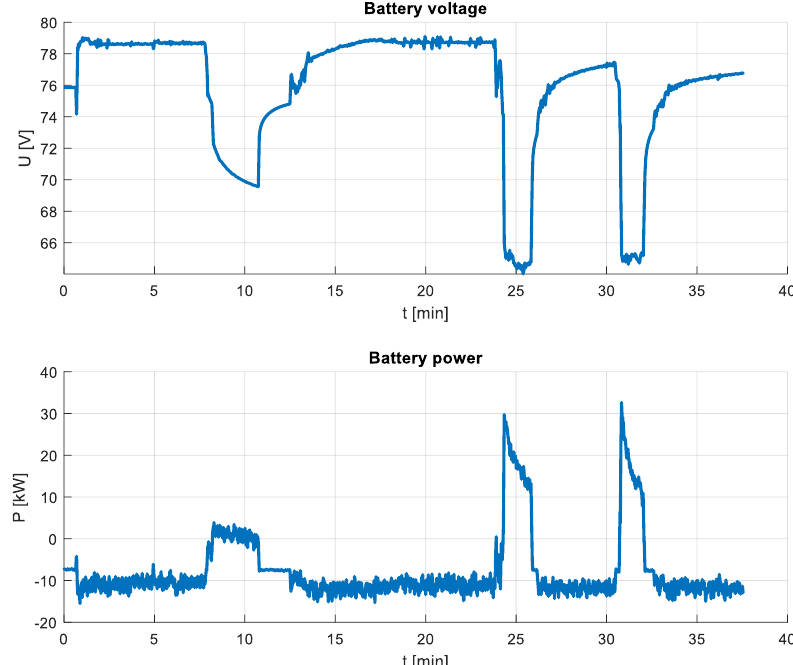
Figure 8. The courses of the battery voltage and power in the field tests of the tractor-trailer unit: minutes 8 to 11 — driving a loaded tractor-trailer unit up a 5° hill; minutes 24 to 26 and 31 to 32 — driving a loaded tractor-trailer unit up a 15° hill (author: Petr Procházka). One of criteria for assessing the trailer hybrid drive during the field tests was its uti- lization rate when driving over the difficult terrain during one working shift. At a short distance of 100 m, the operation of the hybrid drive of the trailer performed in a fully sustainable manner at all the potentiometer settings in the given working conditions. When the tractor-trailer unit travelled over a distance of 500 m (Figure 9), the operation of the hybrid drive was sustainable, without additional recharging of the battery, but only if the potentiometer of the power control of the trailer hybrid drive was set to 50%. At the potentiometer setting of 75%, the tractor-trailer unit was able to work throughout the shift. However, at the end of the shift, after seven working cycles, the hybrid drive battery charge was 53% of its full capacity, and the battery had to be recharged before the begin- ning of the next working shift. When the potentiometer was set to 100%, the hybrid drive of the tractor-trailer unit could be utilized for this forwarding distance only in three work- ing cycles. After these three working cycles, the charge of the battery decreased to 8% of its full capacity. When the tractor-trailer unit travelled over a distance of 1000 m, the long- term operation of the hybrid drive was again sustainable only if the potentiometer was adjusted to 50%. If it was adjusted to 75%, in the selected terrain, the tractor-trailer unit was capable of three journeys with the support of the hybrid drive. Subsequently, the level of the battery charge dropped to 9% of its full capacity. When the potentiometer was set to 100%, the tractor-trailer unit with the hybrid drive was able to realize only one working cycle, after which the level of the battery charge was 10% of its full capacity.